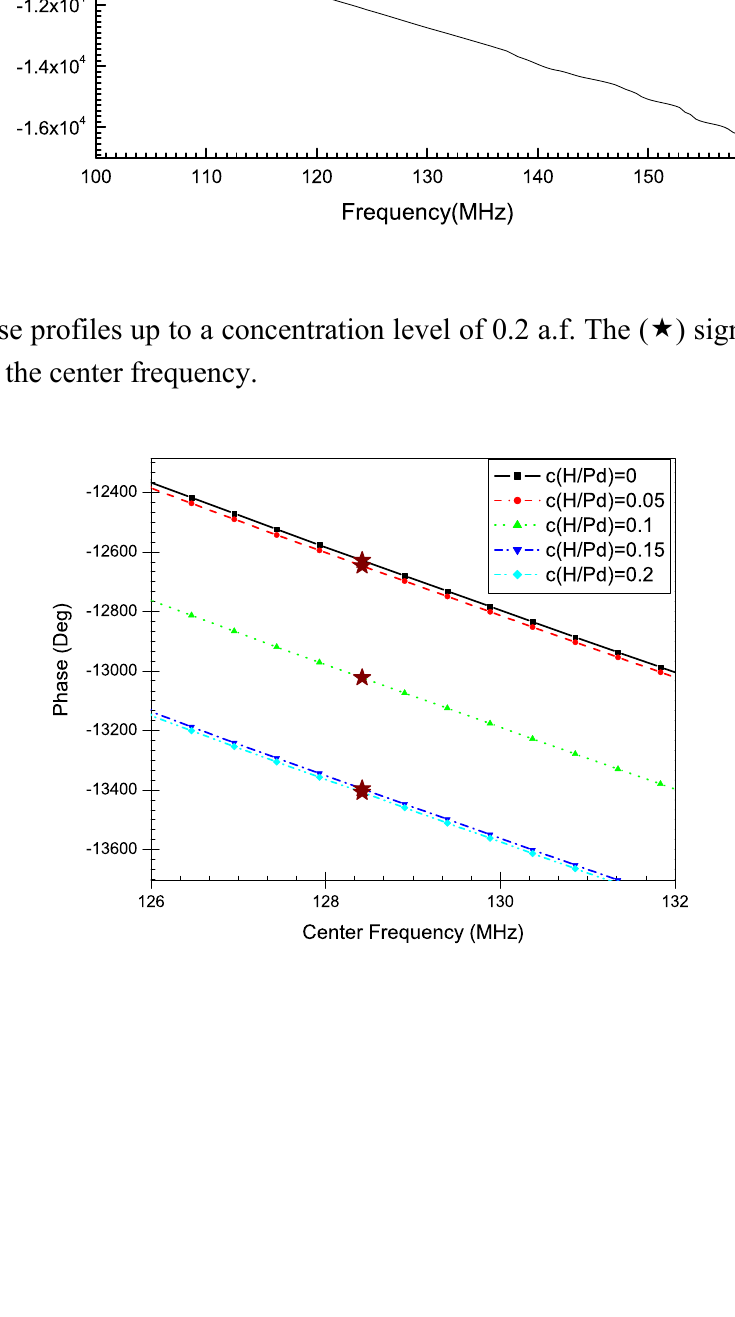
Figure 6. Frequency response for the pure Pd case, f